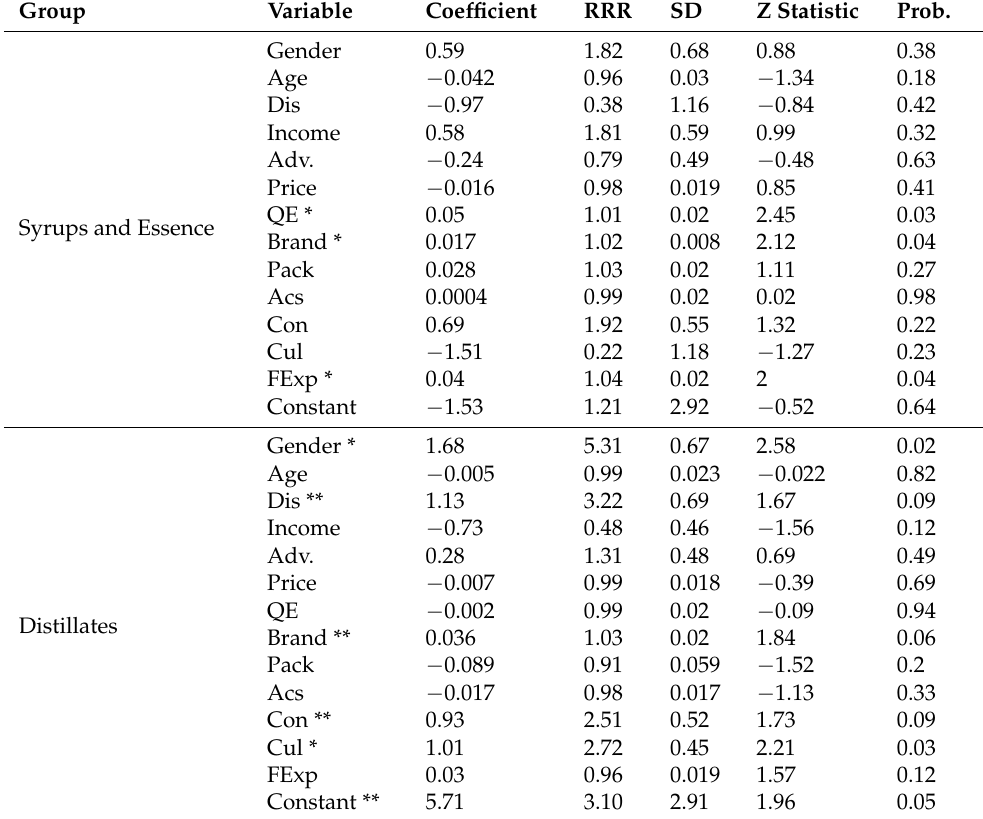
Table 4. The results of estimating the multinomial logit model for the groups of dependent variables (base group is fresh and dried herbs with the highest